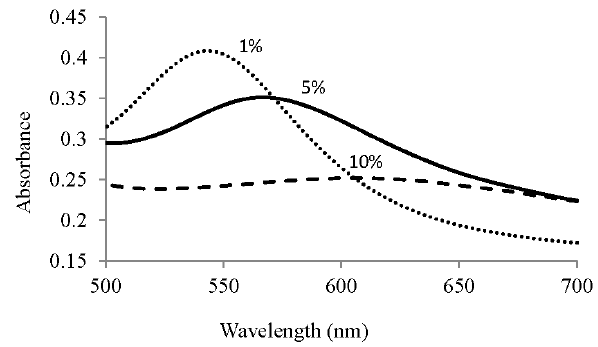
Figure 1. Visible absorbance spectra for AuNPs produced using 1, 5, and 10% tea solutions.